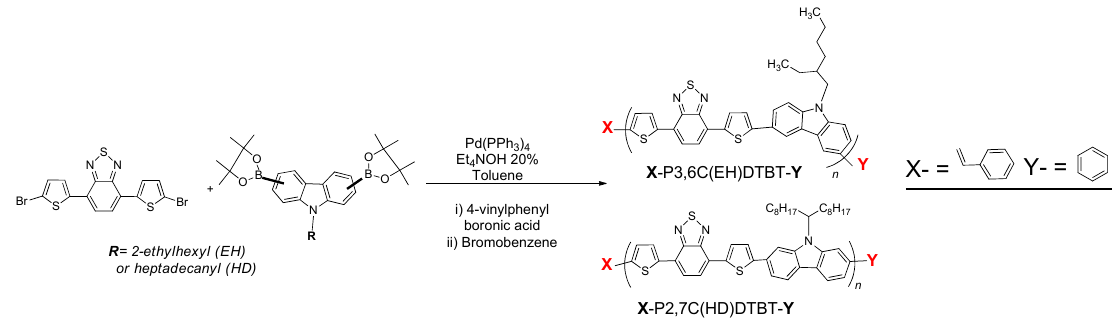
Scheme 1. General synthetic procedure for ω -vinyl functionalized PCDTBTs.